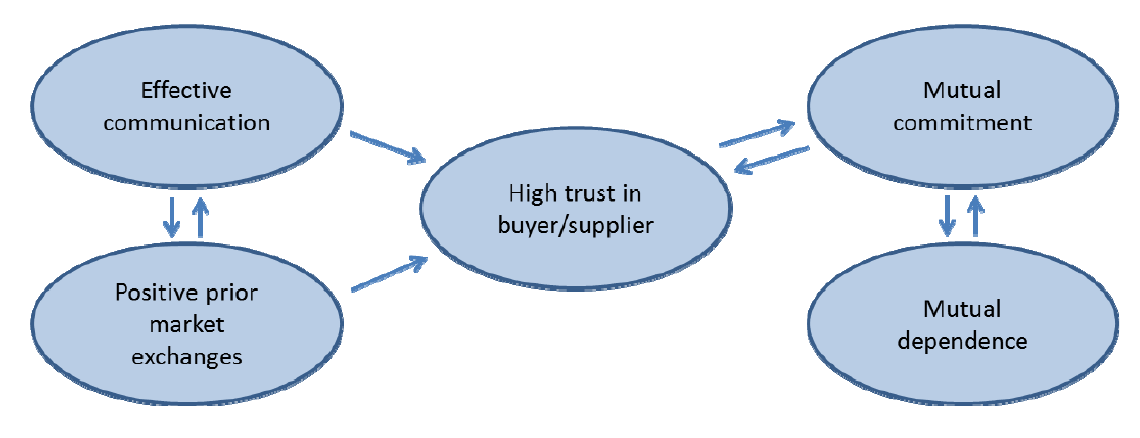
Based on findings from Fischer (2013); Holm, Eriksson, & Johanson (1998); Kwon & Suh (2004); and Morgan & Hunt